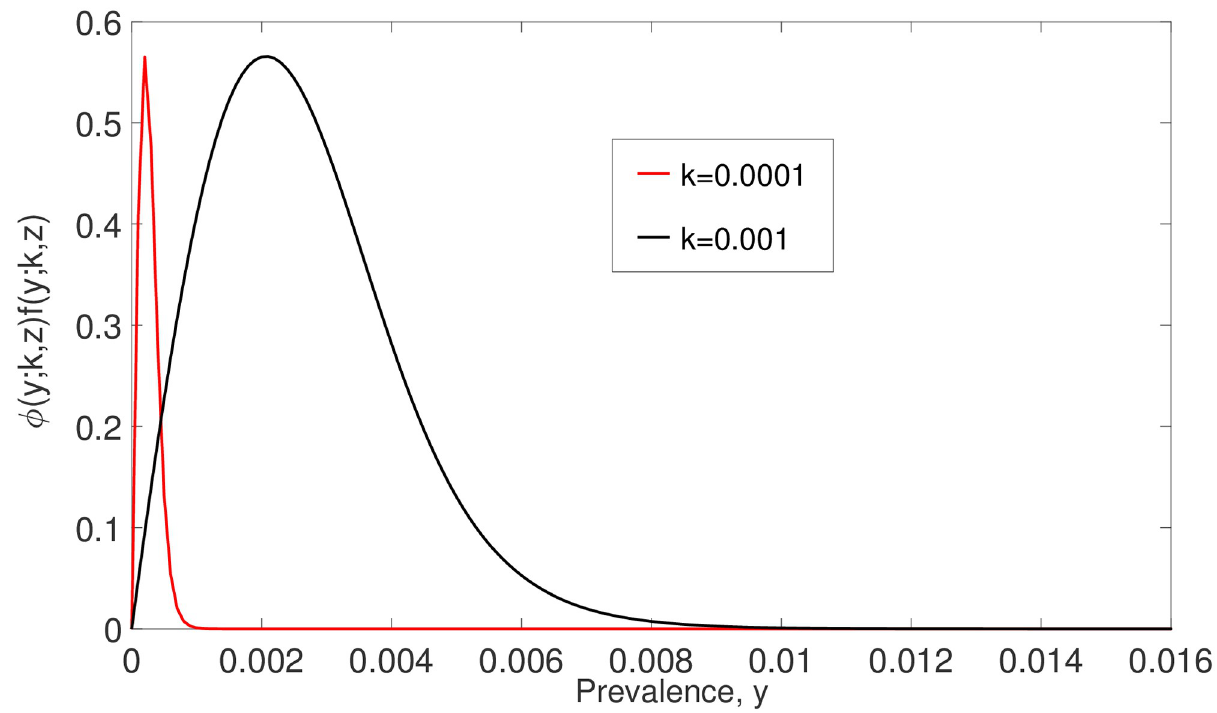
Fig 10. The relationship between F ð y ; k ; z Þ and y by varying parameter k . F ð y ; k ; z Þ is zero almost everywhere as k ! 0.